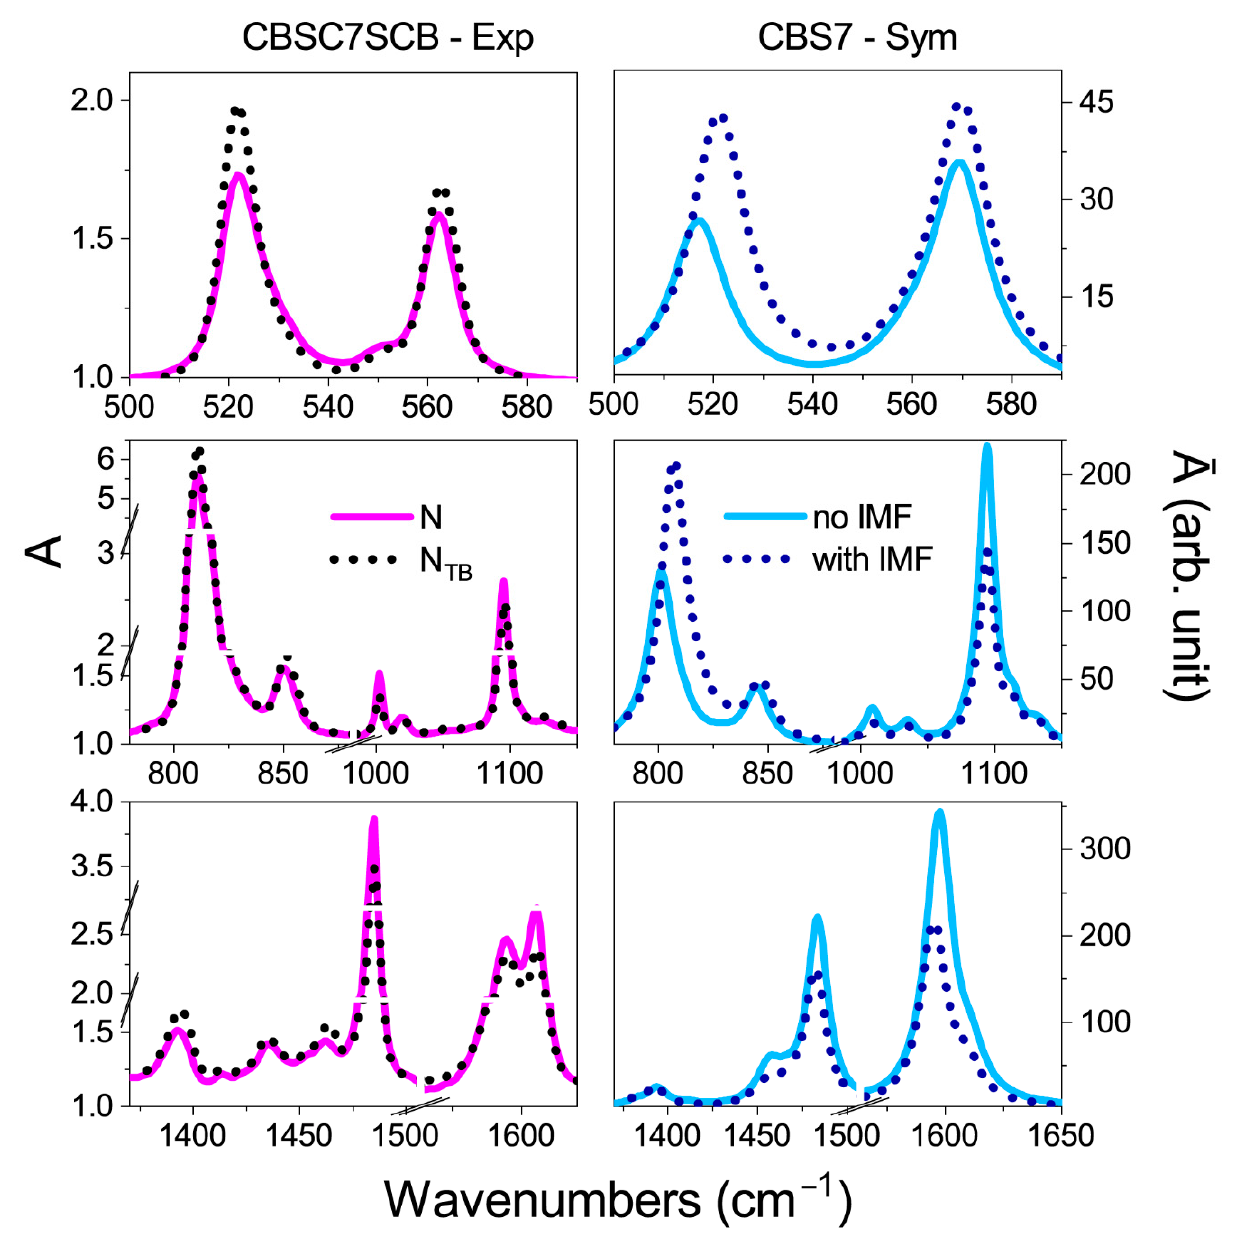
Figure 4. Comparison of the theoretical and experimental spectra for the symmetric dimer. Left Panel: Experimental spectra of the CBS7SCB dimer, solid magenta line—the nematic phase, short black dotted line—the twist–bend nematic phase (spectrum is represented for 5 µ m cell). Right Panel: Simulations for the CBS7 monomer: solid blue line—spectra for an isolated molecule (no IMF), short navy dotted line—a system of six interacting molecules (with IMF).